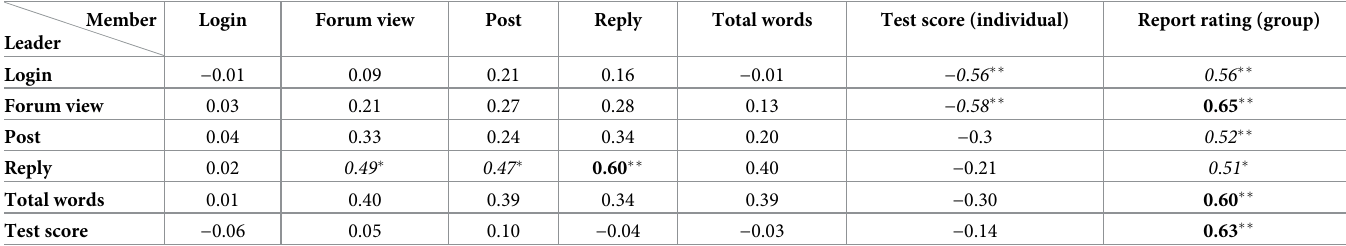
Table 2. Correlations between leader performance and member performance. Member